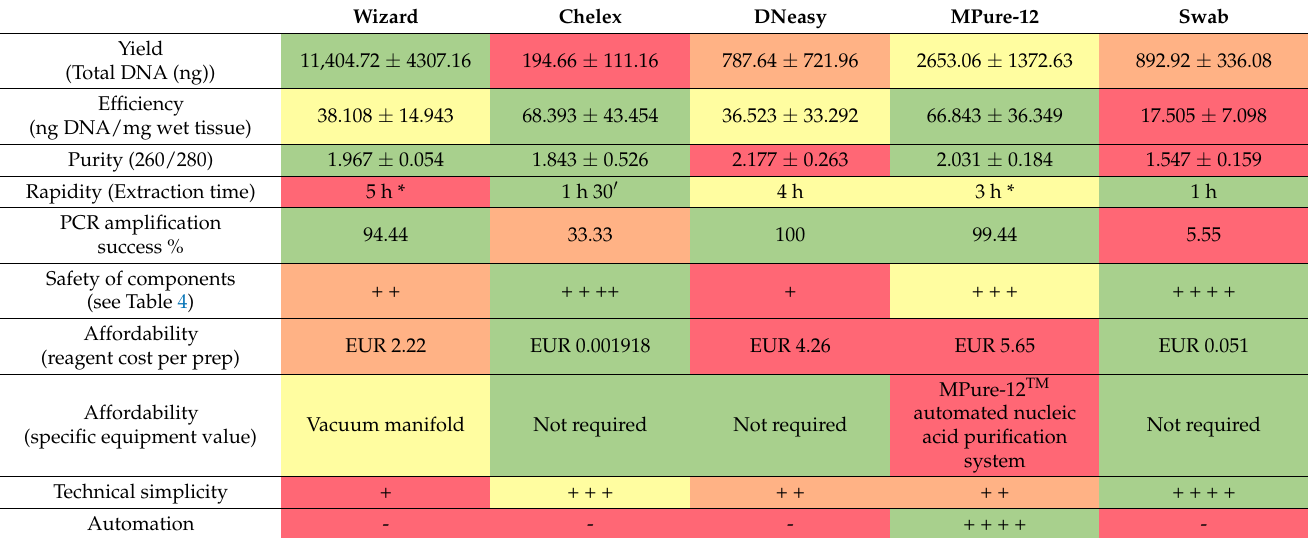
Table 6. Parameters measured for comparison of the tested DNA extraction methods. In the case of non-quantitative variables, the measurement scale ranges from + to ++++ (minimum to maximum, respectively). The measurements are highlighted according to a color scale (green, yellow, orange, and red), indicating a scale of values, from best (green) to worst